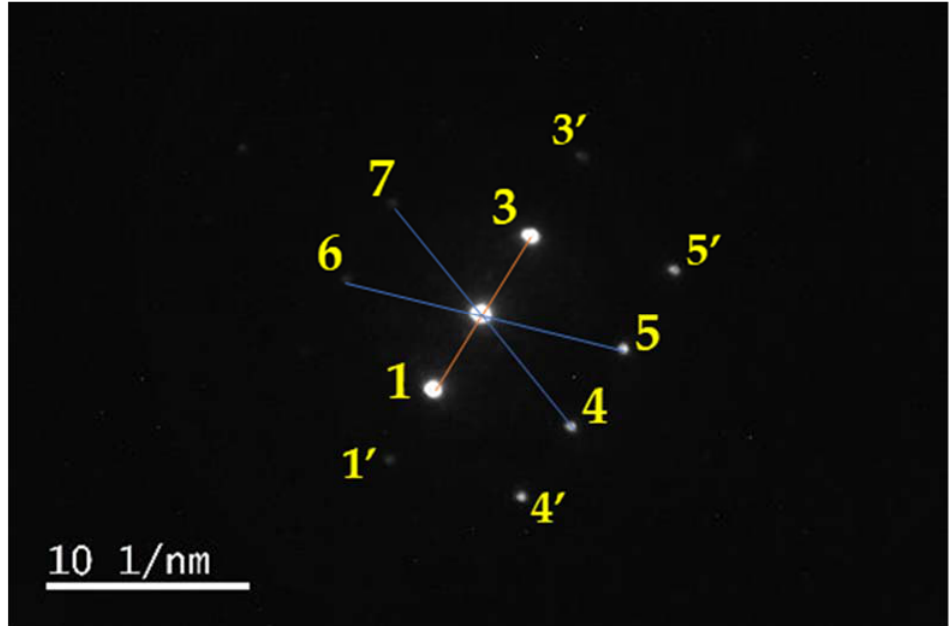
Figure 9. The transmission electron microscopy (TEM) of [Cu(12 ‐ crown ‐ 4) 2 ]I 5 : Electron diffraction pattern along lattice fringes. Main central spots from down ‐ left to up ‐ right 1 ‐ 2 ‐ 3 (orange). There are three bright spots (named here as 1,2, and 3) in the center of the electron diffraction pattern (Figure 9). These spots are arranged perpendicular to the lattice fringe. The brightest central spot (2, {000}) has two slightly different distances to the two neigh ‐ boring points 1 and 3 (Figure 9). The lower spot (1) and the upper spot (3) are connected 4.4731 1/nm and 4.66 1/nm for 1-2 and 2-3, respectively (Figure 8). Point 1 has a dis- tance of 4.25 1/nm to the neighboring unnumbered weak spot 1‘ towards the lower left side (Figure